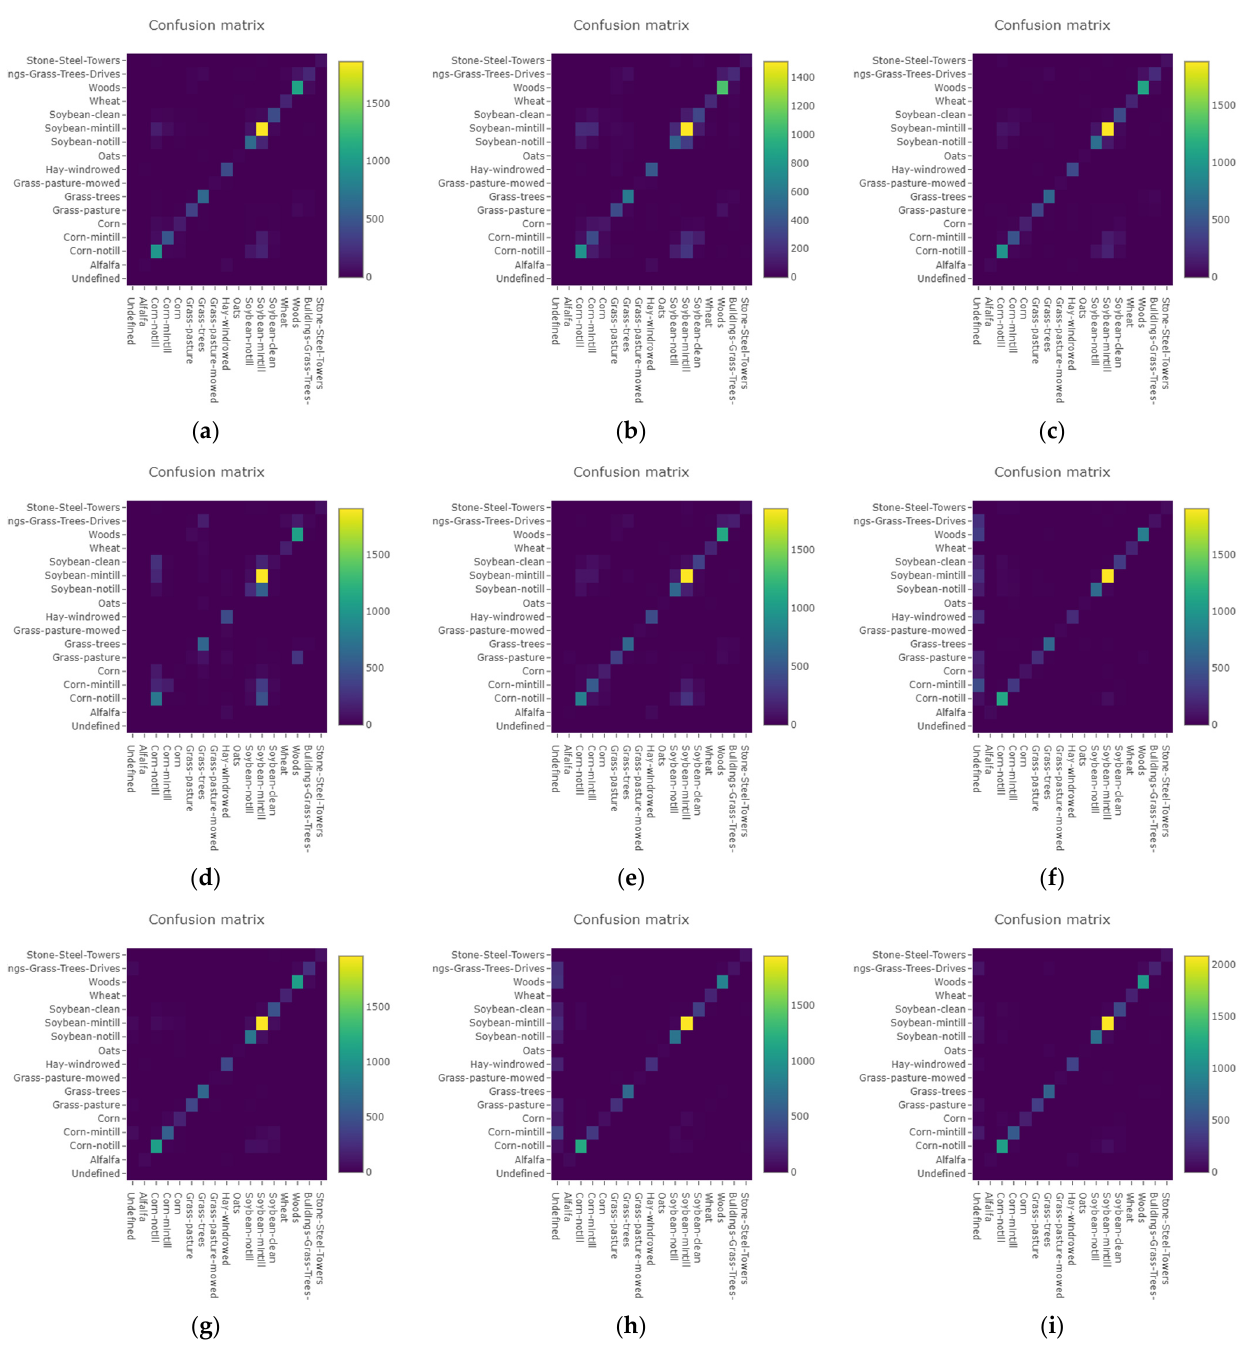
Figure 14. Confusion matrixes of the nine models on the Indian Pines dataset. ( a ) SVM. ( b ) RNN. ( c ) ANN. ( d ) 1D CNN. ( e ) SF. ( f ) 3D CNN. ( g ) Hamida. ( h ) HybridSN. ( i ) ESFNet.